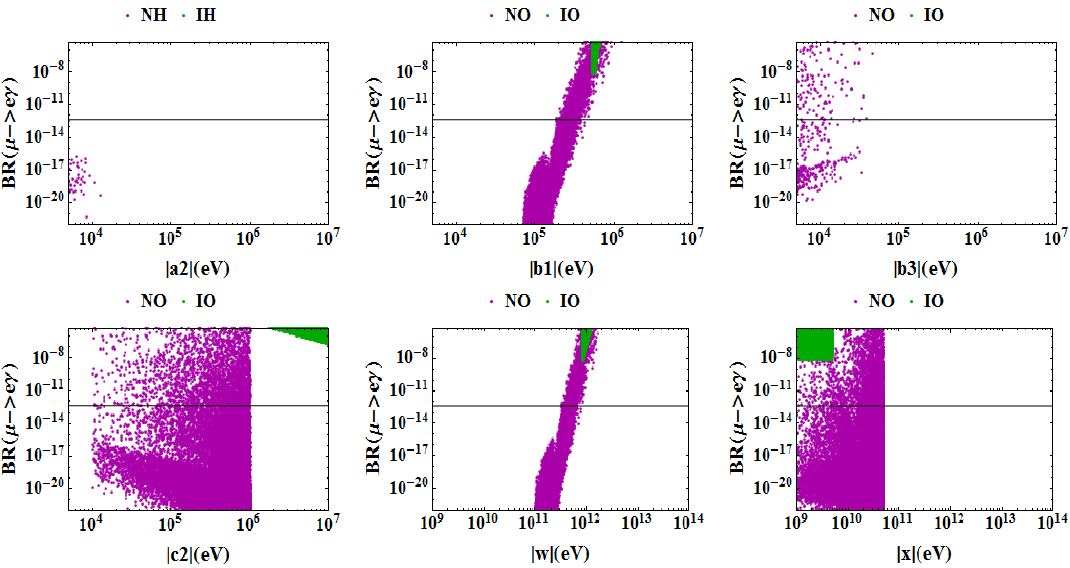
JHEP06(2019)064